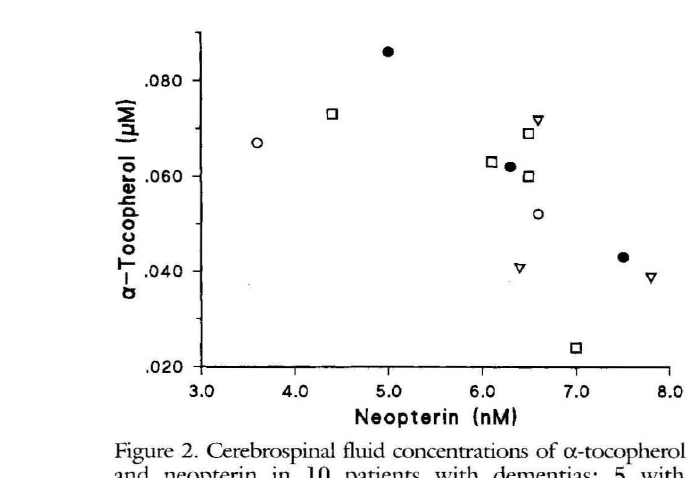
Figure 2. Cerebrospinal fluid concentrations of a-tocopherol and neopterin in 10 patients with dementias: 5 with Alzheimers disease (open squares), 2 with Huntingtons disease (open circles), 3 with vascular dementia (open triangles) and 3 controls (closed circles) (all data, n = 13: rs=-0.678, p<O.OI; dementias only, n=9: rs=-0.579, p